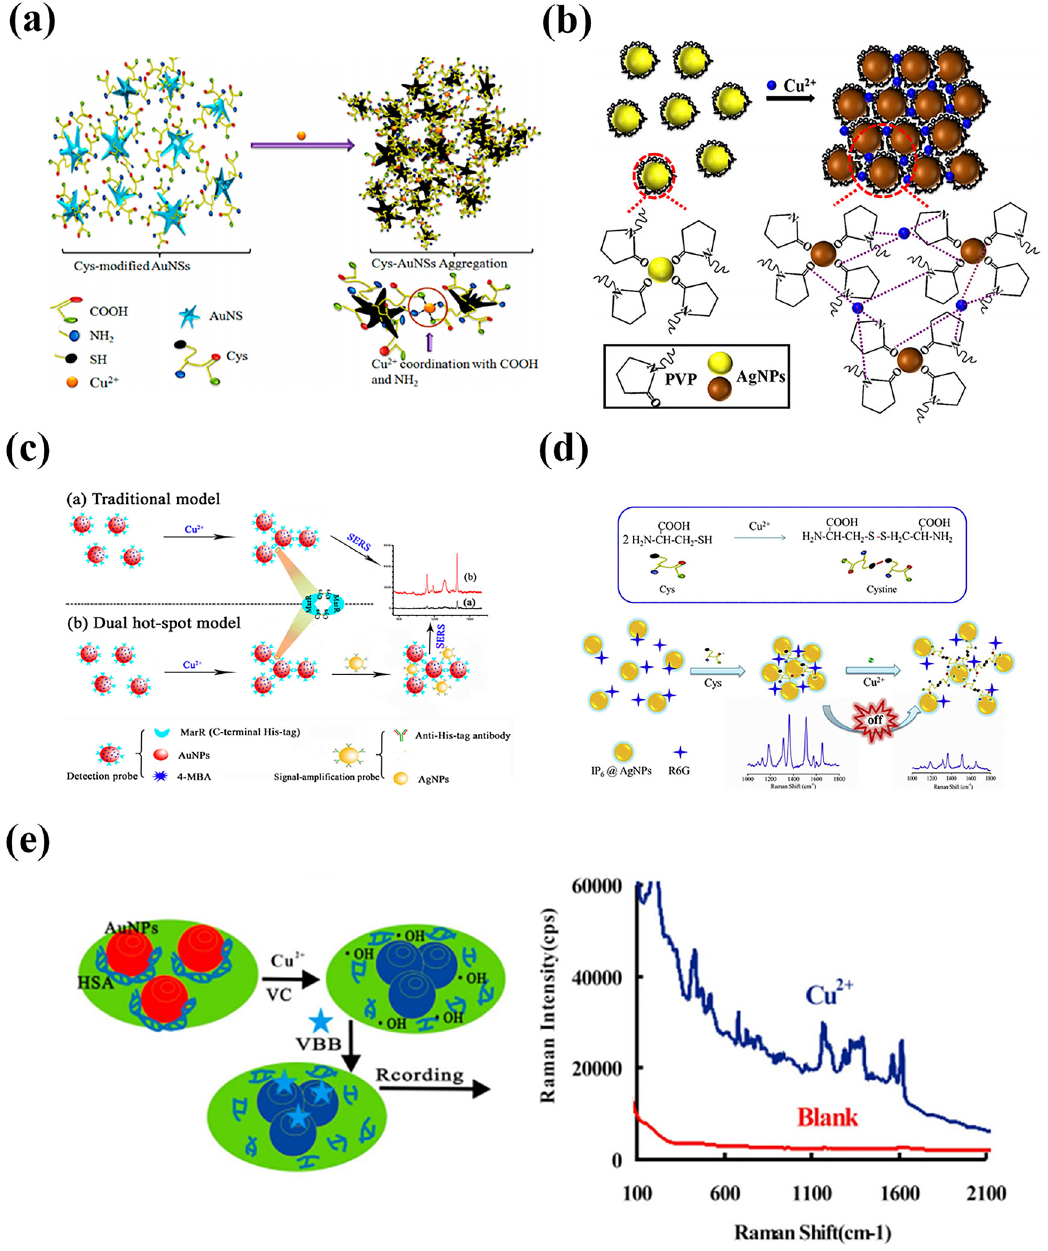
Figure 4: SERS-based Cu 2 + ions detection. (a)Cu 2 + ionsbondwithcysteine[72].(b)Cu 2 + ionslinkedwithPVP[77].(c)Adualhotspotsignalampli fi cationstrategybasedonantigen – antibody reaction [78]. (d) Cu 2 + ions oxidized L -cysteine to cystine [79]. (e) Taking place catalytic reaction and generating strongly oxidizing (cid:129) OH in the presence of Cu 2 + ions